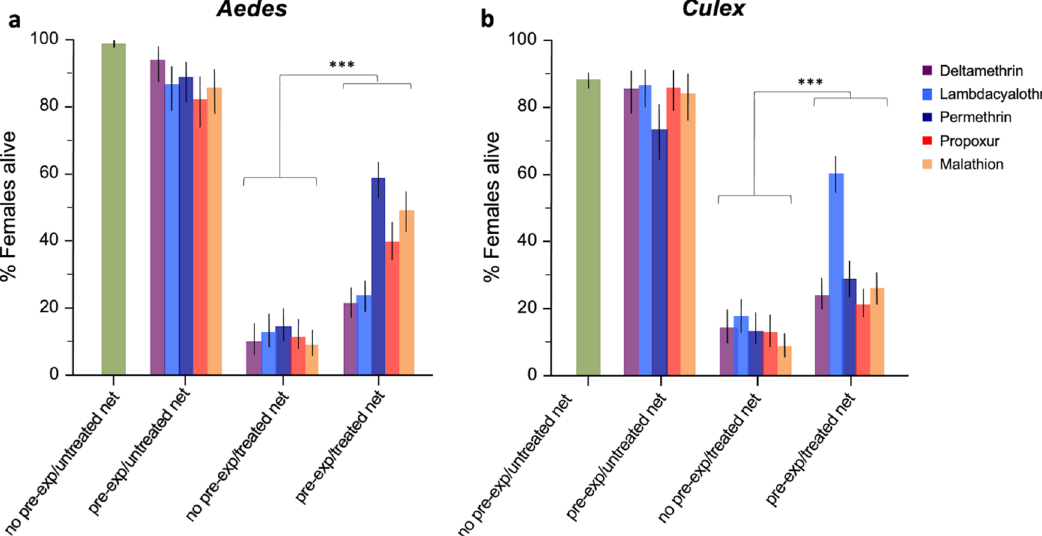
Figure 3. Proportion of surviving unconditioned and conditioned ( a ) Aedes aegypti and ( b ) Culex quinquefasciatus females exposed to untreated and treated bed nets in the WHO tunnel tests. Error bars represent 95% confidence intervals. P values are P < 0.001